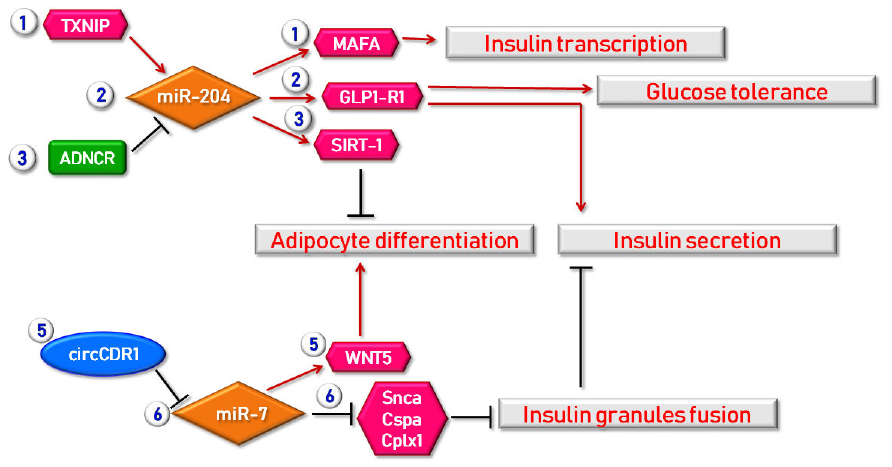
Figure 2. Examples of regulatory mechanisms in which lncRNAs, circRNAs and miRNAs are in- volved in obesity and β cell function. A first mechanism through which beta cell function is regulated by miRNAs is the TXNIP/miR-204/MAFA regulatory axis. Indeed, TXNIP (Thioredoxin-Interacting Protein) is able to induce miR-204 expression consequently leading to MAFA suppression and finally to insulin transcription inhibition. The same miR-204 also targets and regulates the expression of GLP1R (Glucagon-Like Peptide 1 Receptor) thus improving both insulin secretion and glucose tolerance. Moreover, miR-204 expression is also regulated by ADNCR (Adipocyte Differentiation- Associated lncRNA) lncRNA, thus leading to SIRT-1 overexpression, finally resulting in the repression of adipocytes differentiation. As a matter of fact, adipocyte differentiation is also regulated by circ- CDR1 acting as miRNA regulator for miR-7, in turn modulating WNT5 expression. Furthermore, miR-7 is also involved in insulin secretion modulation; indeed, this miRNA directly inhibits genes acting in insulin granules fusion (Snca, Cspa, Cplx1). Red arrows indicate enhancement/stimulation, while black lines represent